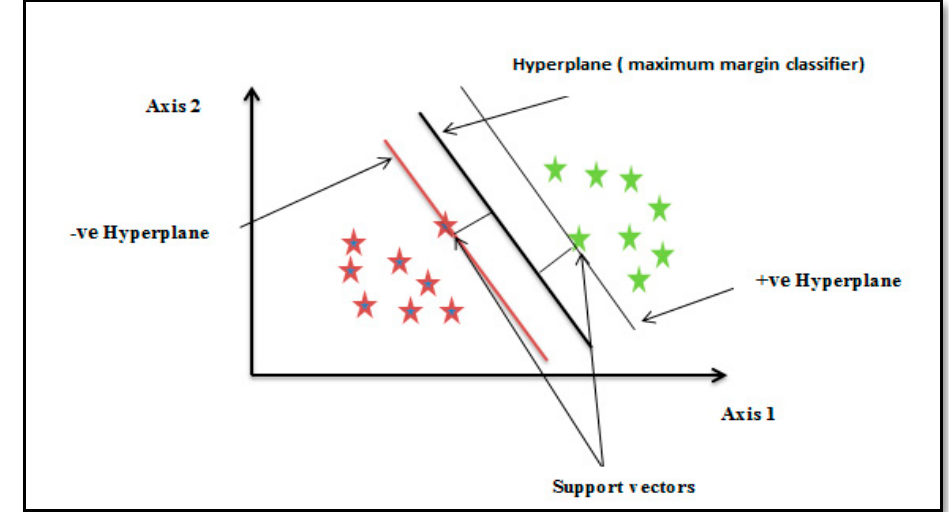
Figure 9. Hyper-plane separation between two Figure 9. Hyper ‐ plane separation between two datasets.